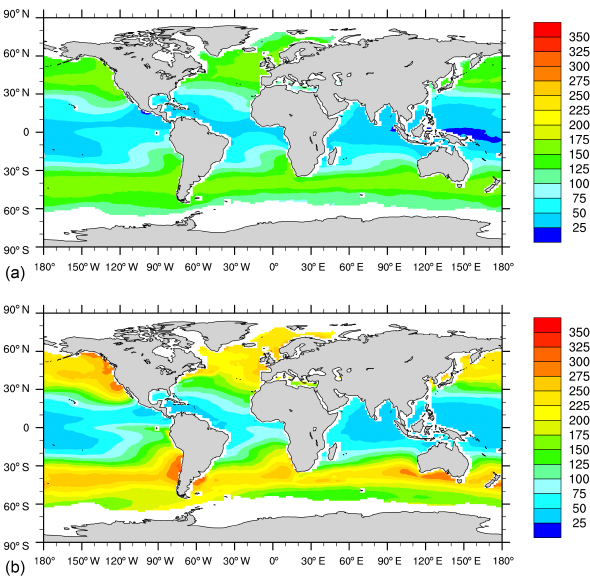
Figure 9. Average relative difference (%) for the year 2006 between the ozone dry deposition velocity ( v d , cms − 1 ) modelled using the one-layer reactivity scheme and the two-layer reactivity scheme (a) , and that between the default scheme (with surface resistance r c = 2200sm − 1 ) and the two-layer reactivity scheme (b)